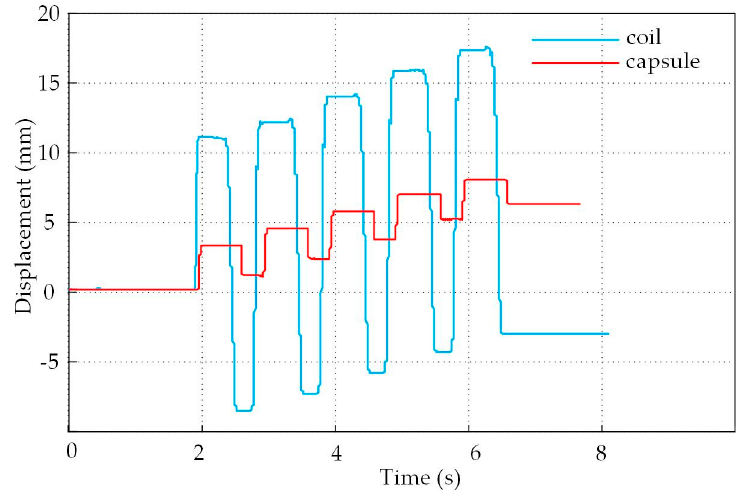
Figure 9. The forward displacements of the CR and the small coil.